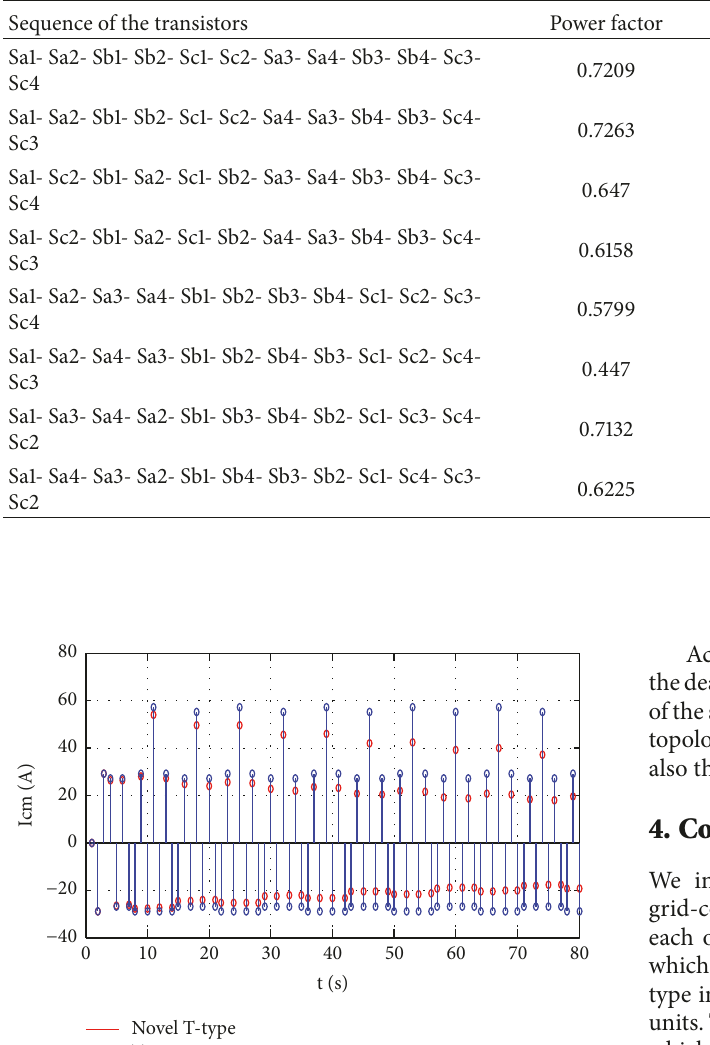
Table 8: Comparison of output parameters under various switching sequence (simulation time: 0.1s).